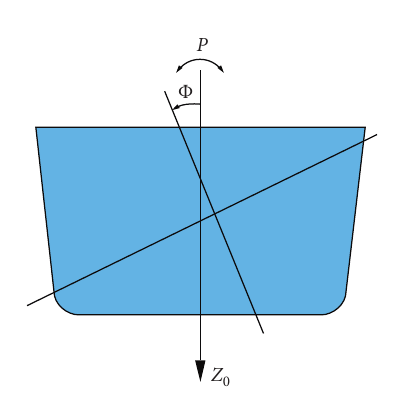
Figure 2: State of ship